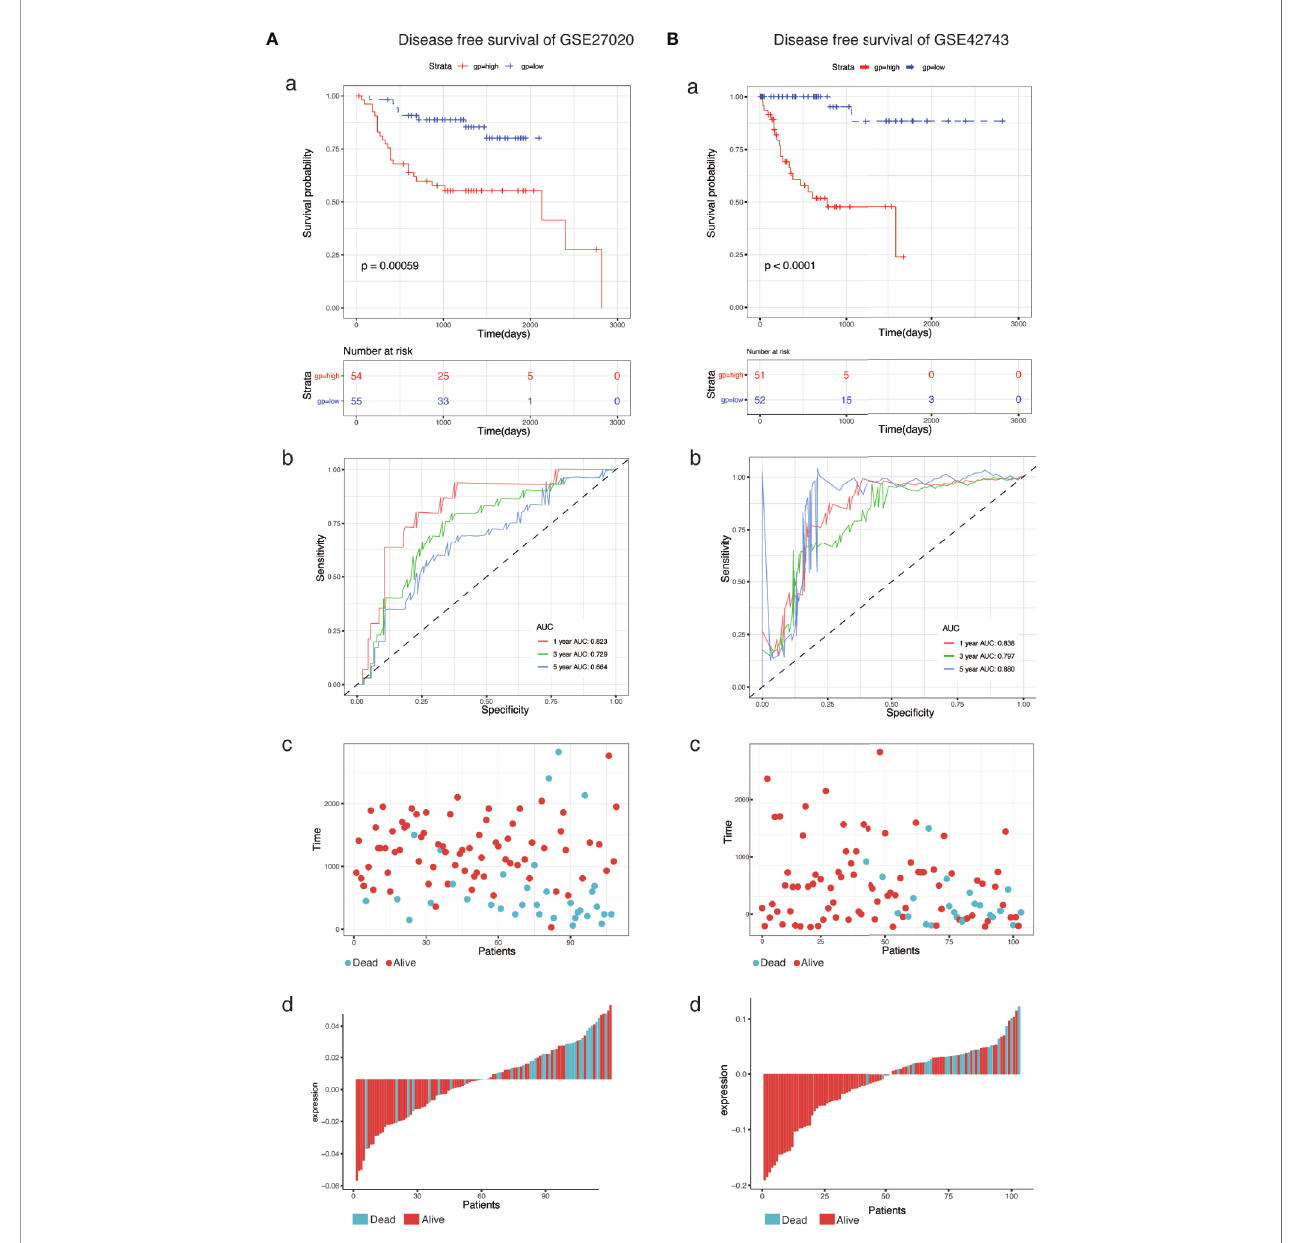
FIGURE 4 | KM survival, risk score by eight-gene signature and time-dependent ROC curves in the DFS validation datasets. (A) GSE27020, (B) GSE42743. (a) KM survival analysis between high and low risk samples. (b) Time-dependent ROC curve for overall survival of validation datasets, the AUC was assessed at 1-, 3- and 5-years. (c) Relationship between survival time (day) and risk score rank. (d) Relationship between survival status and risk score